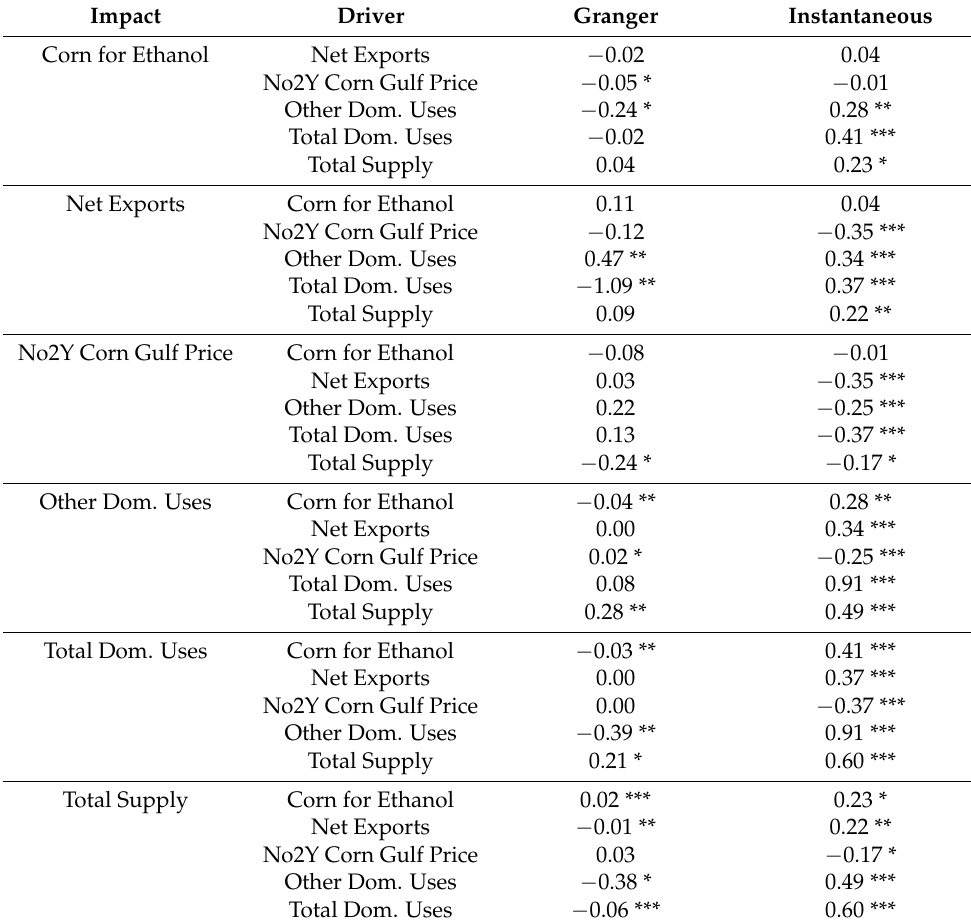
Table 2. Granger and instantaneous causality test results (Significance: *** = 1%, ** = 5%, * = 10%).